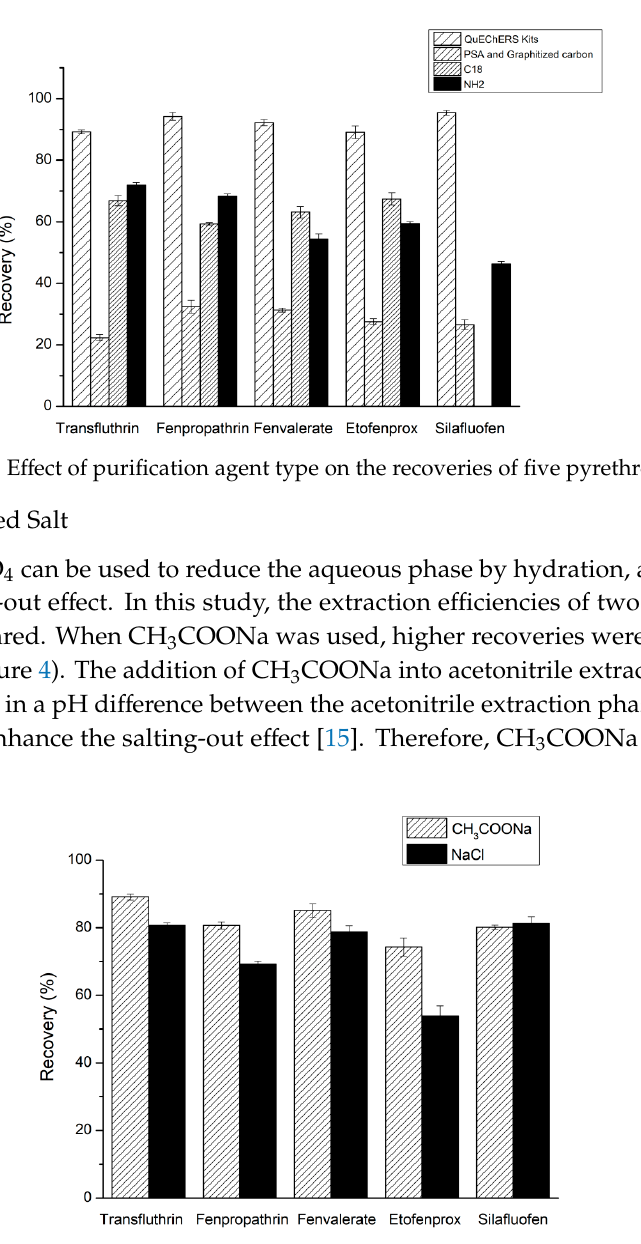
Figure 4. Effect of added salt type on the recoveries of five pyrethroids.